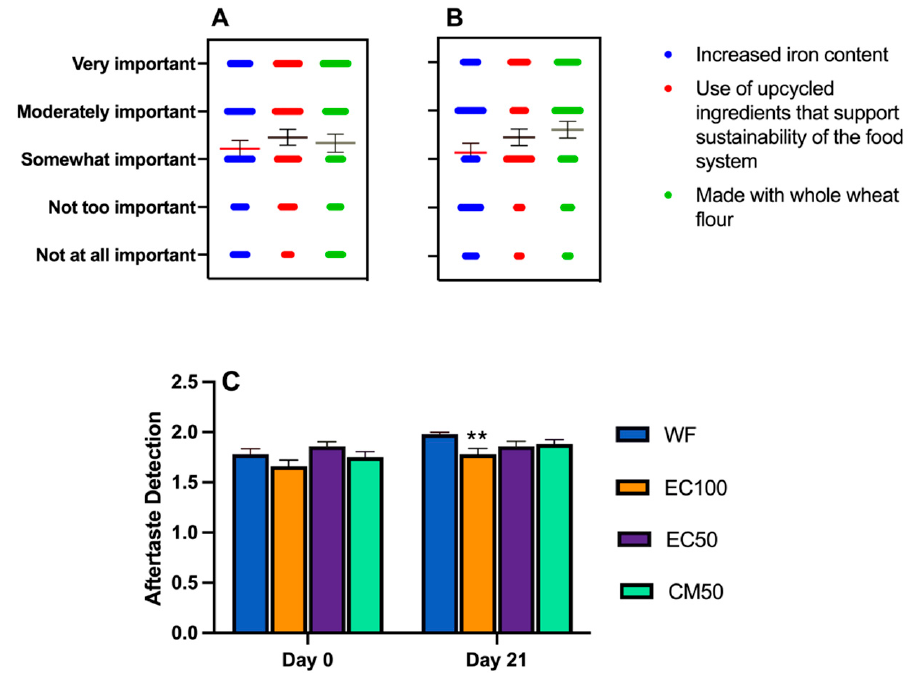
Figure 8. Claims provided for purchase intentions (means ± S.E.) during ( A ) day 0 and ( B ) day 21. A wider band corresponds to higher importance given by the panelist; ( C ) aftertaste detection (means ± S.E.) in whole wheat flour (WF) roti (Indian flat bread) samples fortified with encapsulated defatted Nannochloropsis oceanica (EC) and color ‐ masked defatted Nannochloropsis oceanica (CM) on days 0 and 21; n = 58 (Day 0) and n = 51 (day 21); ** p < 0.01.